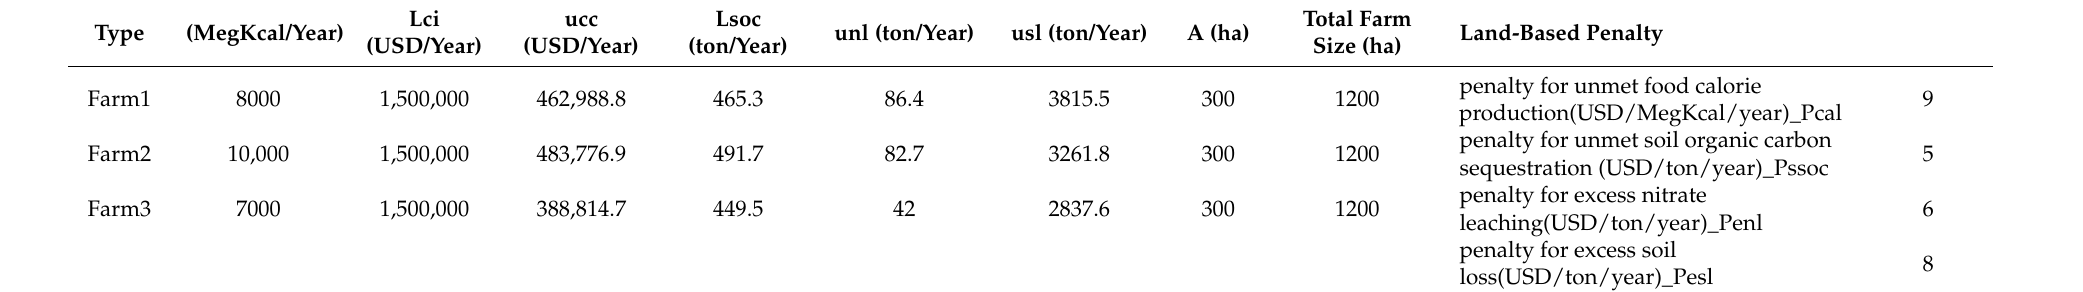
Table 5. Input data used for land-based